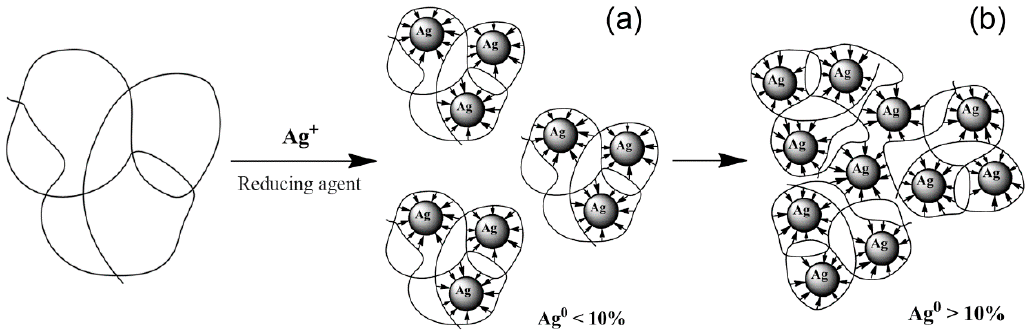
Figure 3. Formation of macromolecular globules during the incorporation of AgNPs into a polymer matrix.